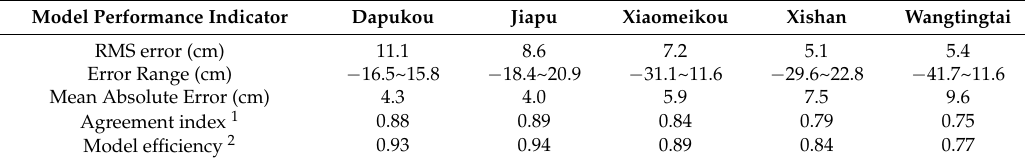
Table 2. Model performance indicators for calibration scenario. Model Performance Indicator